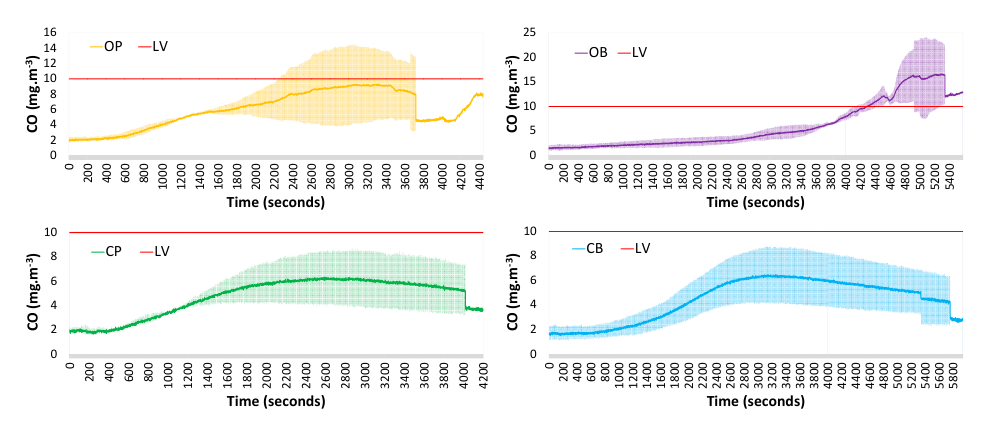
Figure 7. Temporal variability of CO (line—mean; light coloured area—standard deviation) during the combustion period for the four studied conditions: ( top , left ) OP—open fireplace and pinewood, ( top , right ) OB—open fireplace and briquettes, ( bottom , left ) CP—closed fireplace (insert) and pinewood, and ( bottom , right ) CB—closed fireplace (insert) and briquettes. The red line represents the CO limit value of 10 mg·m − 3 defined by the Portuguese legislation [32].